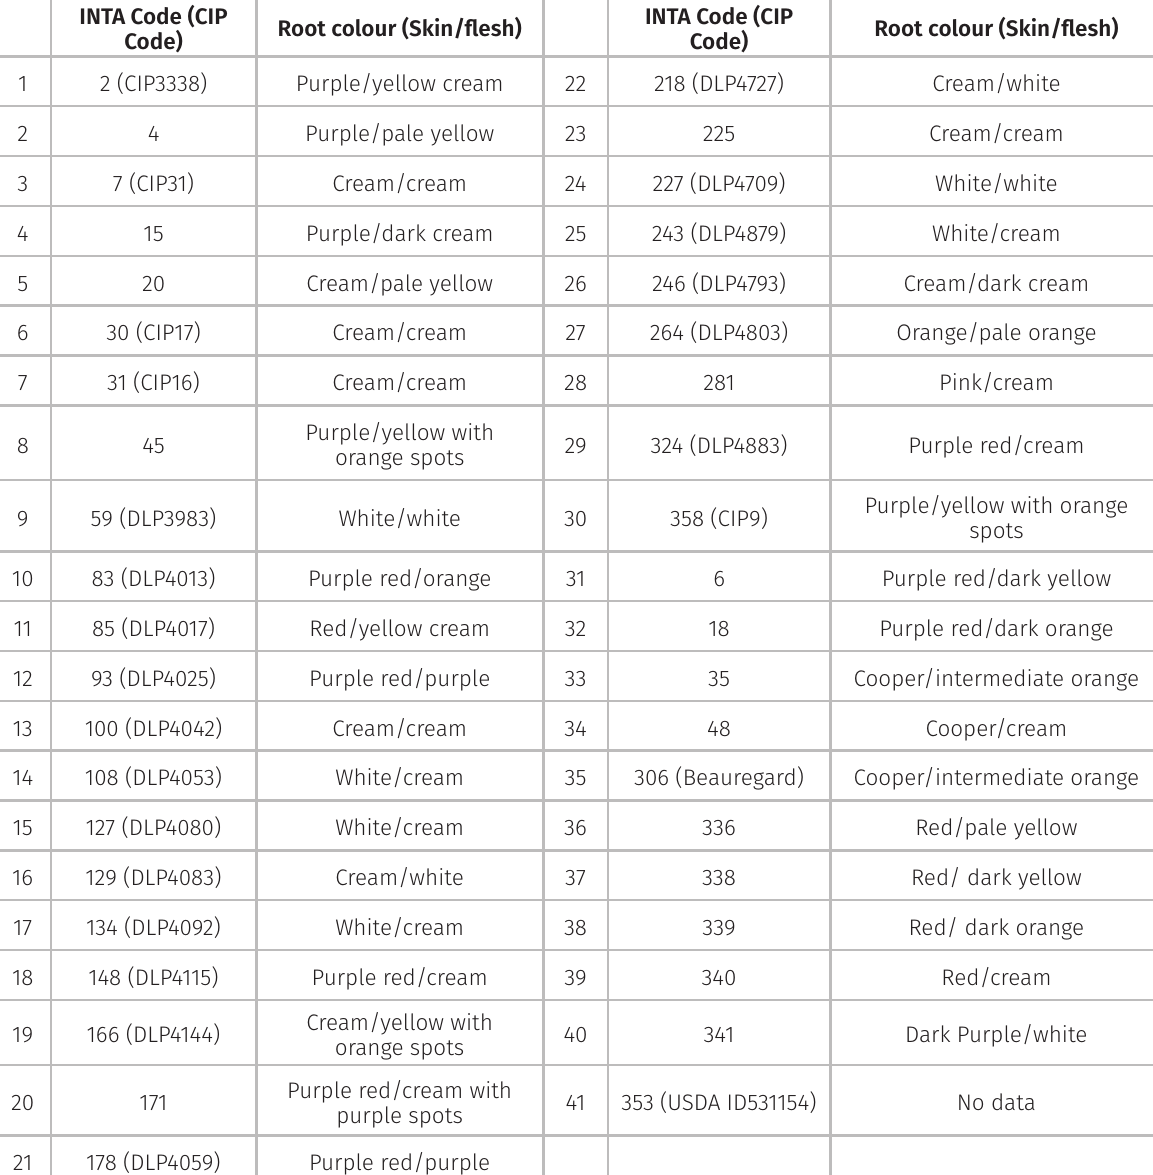
Table I. Set of 41 I. batatas accessions used for allelic diversity